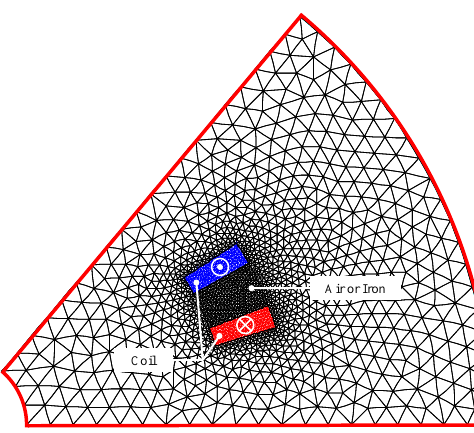
Figure 4. 2-D Finite-Element Analysis (FEA) mesh for the air- or iron-cored coil.